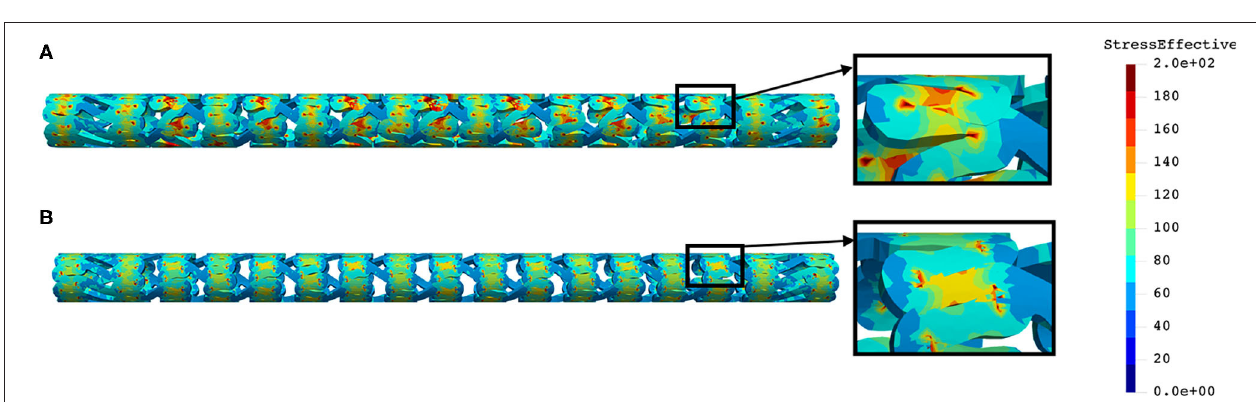
FIGURE 5 | Effective stress distribution on PLLA prot (A) and PLLA prot-slots (B) stents for radial compression